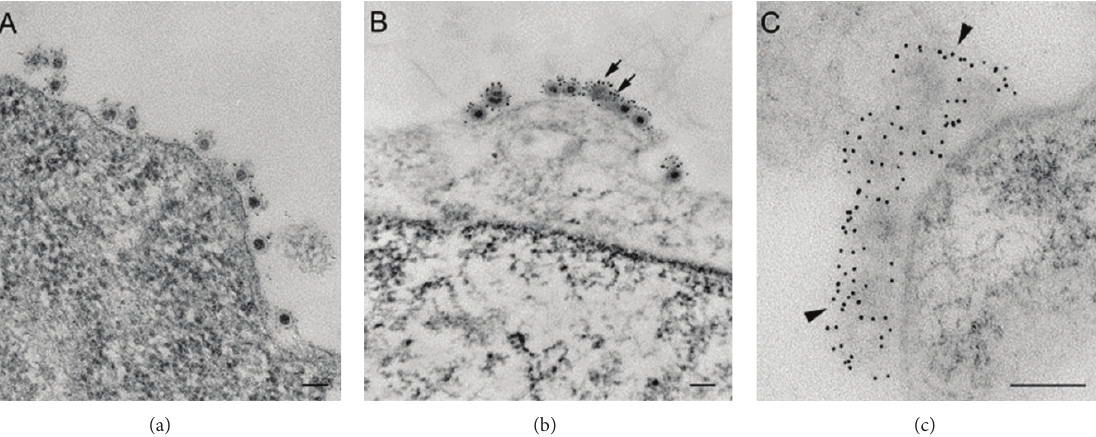
Figure 14: Overview of Sindbis virus-cell complexes. Low magnifications of Sindbis virus-cell complexes at different temperatures. (a) Interaction at 4 ∘ C; (b) interaction at 15 ∘ C; note the presence of both full and empty (arrows) particles; (c) interaction at 37 ∘ C, in which most particles lose their electron density and their well-defined structure (arrowheads). Bars, 100nm. From Vancini et al. 2013